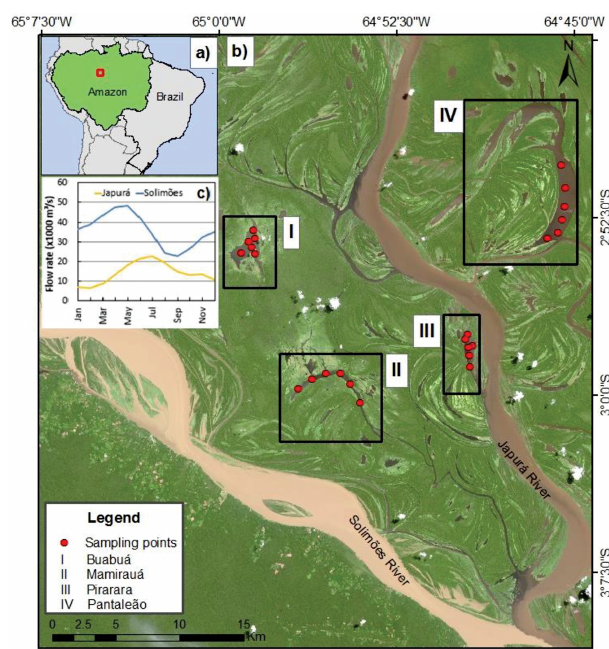
Figure 1. (a) Overview of the Amazon. (b) OLI/Landsat 8 true color image from 30 July 2015 showing the study areas and sampling stations: (I) Buabuá, (II) Mamirauá, (III) Pantaleão and (IV) Pi- rarara. (c) The mean water flow rate (2000–2010) calculated for the Japurá and Solimões rivers (Brazilian Water National Agency – ANA; Agência Nacional de Águas,